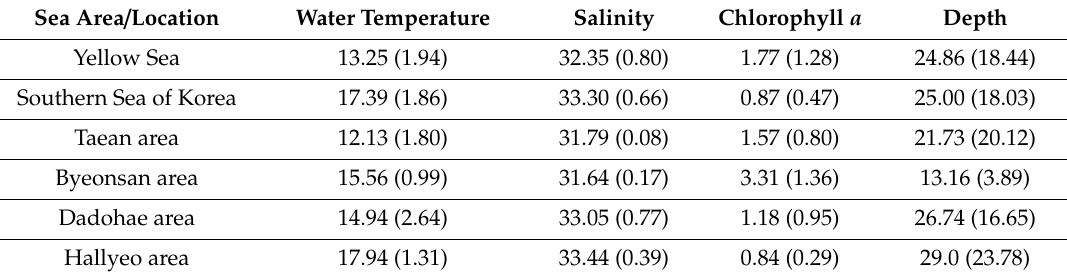
Table 1. Average water temperature, salinity, chlorophyll a concentration, and depth according to the sea area and location in the Marine and Coastal National Park areas of Korea. The average values of the environmental variables according to the sea area are presented as means with standard